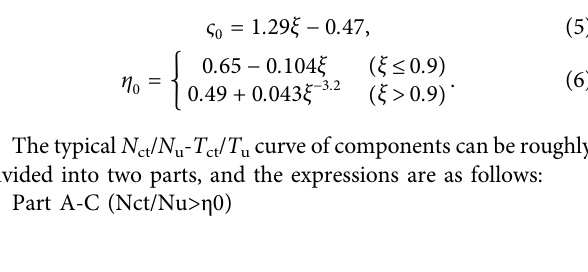
Frontiers in Materials |